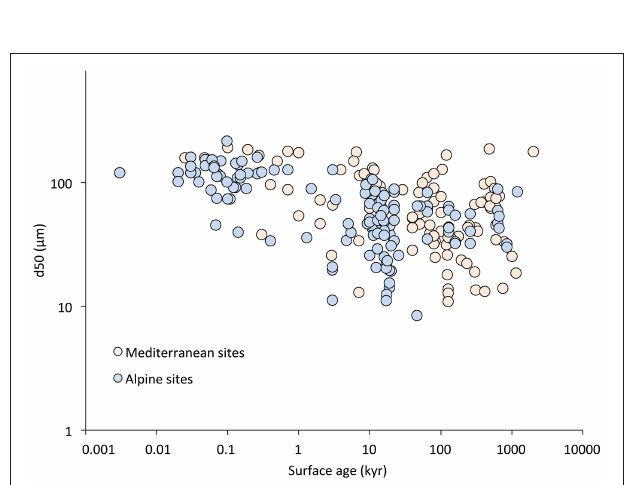
FIGURE 5 | Evolution of the median grain size ( d 50 ) of the soils (alpine or Mediterranean environment) over time. This detectable decrease is significant for both series of soils. It is, however, more significant ( R 2 = 0.47; p < 0.01; power law function) for the alpine region than for the Mediterranean sites ( R 2 = 0.26; p < 0.05; power law